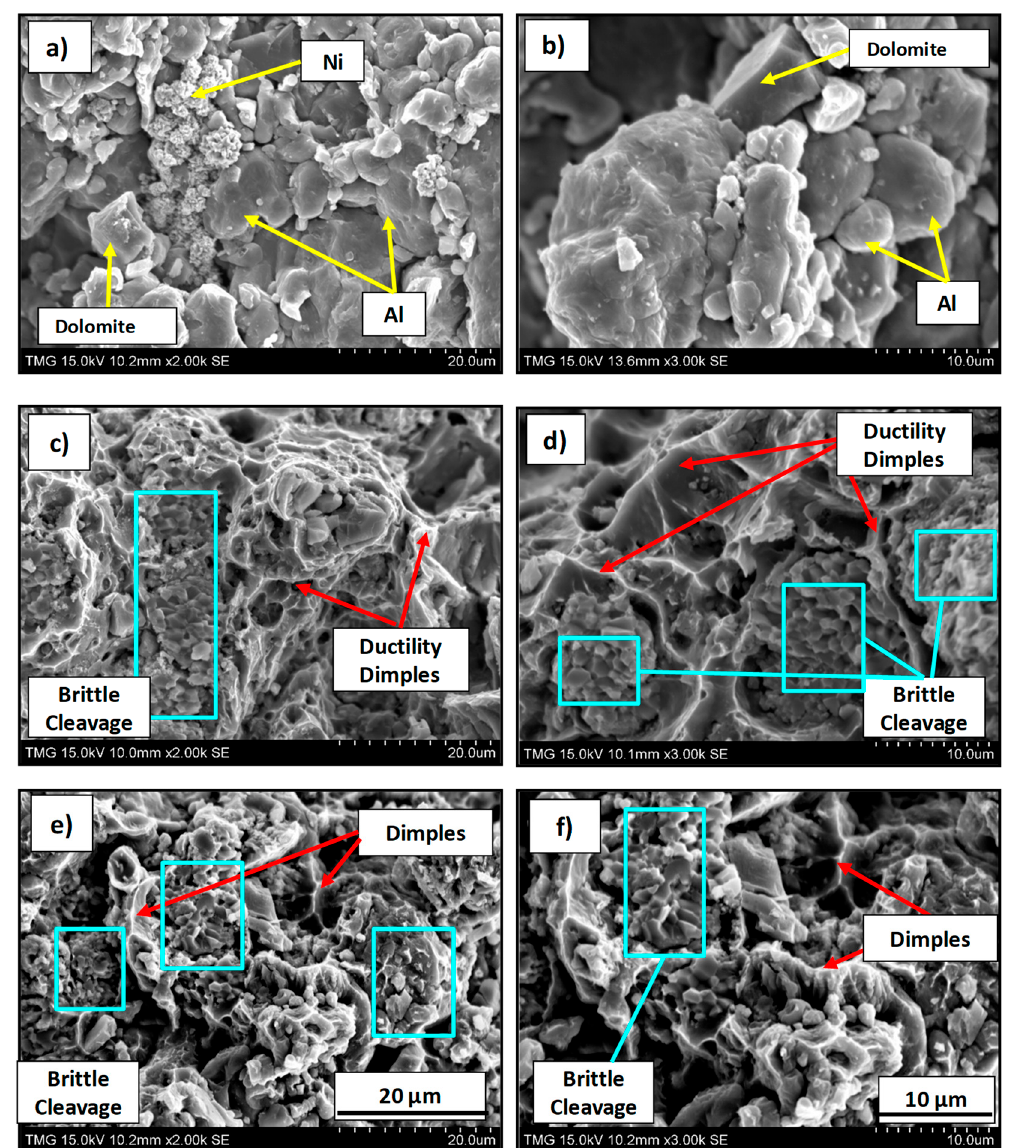
Figure 3. Fracture surface of Al foam containing 10 wt.% Ni (Al–10Ni) with 7 wt.% dolomite compacts with 98% green density: as-compacted ( a , b ); partially sintered I at 450 °C, 15 min ( c , d ); partially sintered II at 450 °C, 20 min ( e , f ).